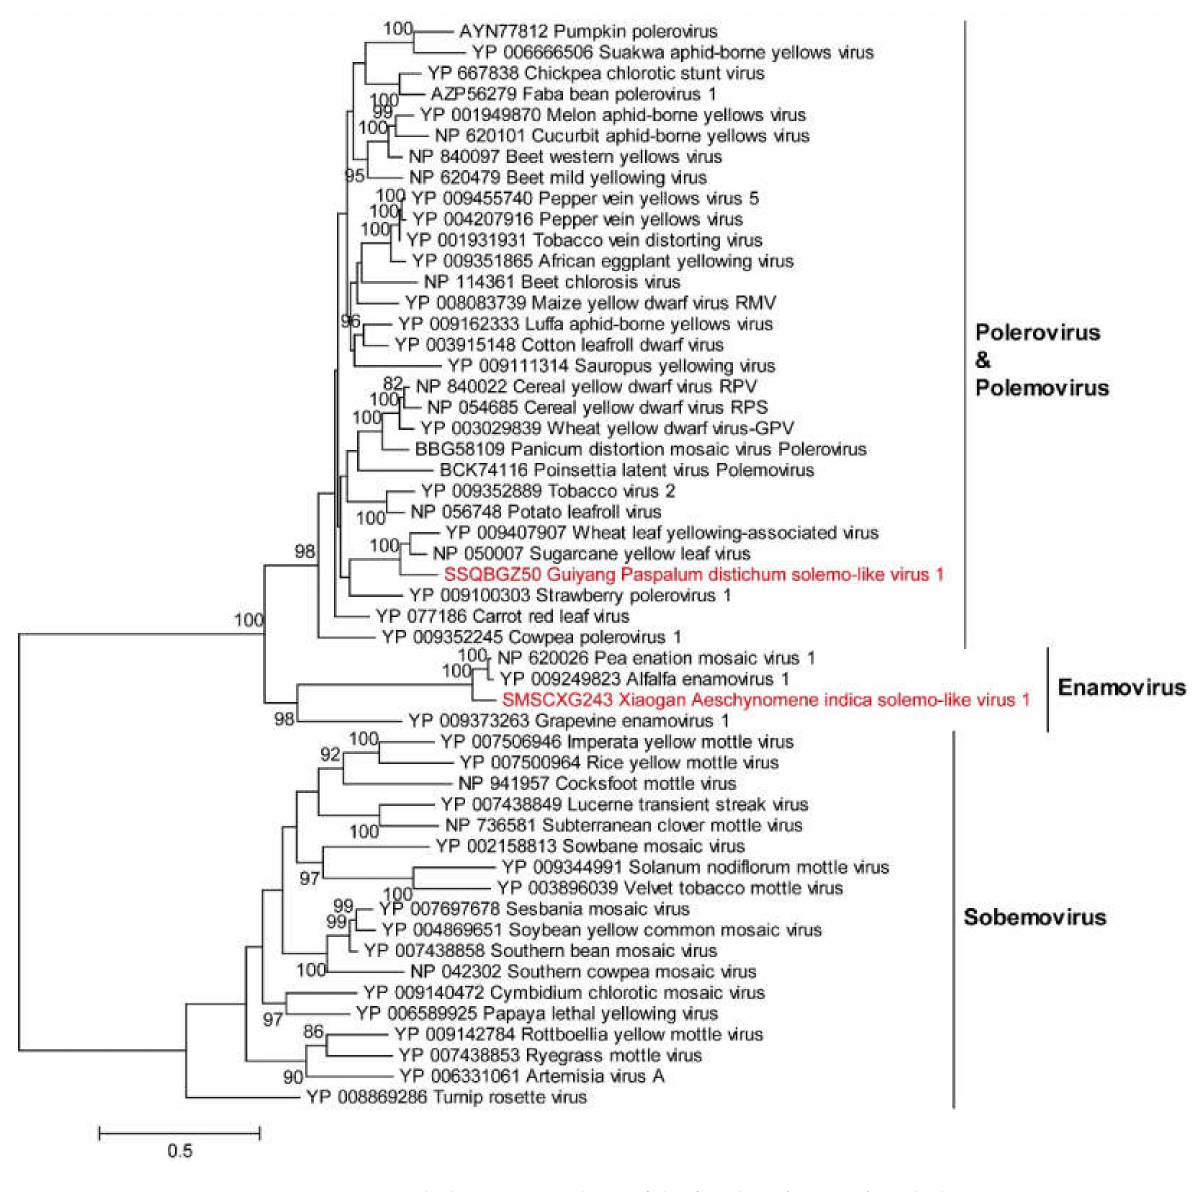
Figure 3. ML phylogenetic analysis of the family Solemoviridae. Phylogenetic trees were constructed using the aligned sequences of RdRp. The names of new viruses discovered in this study are marked in red, the reference virus serial numbers and names are marked in black and the families and genera of viruses (and branches in minimized trees) obtained in this study are marked in